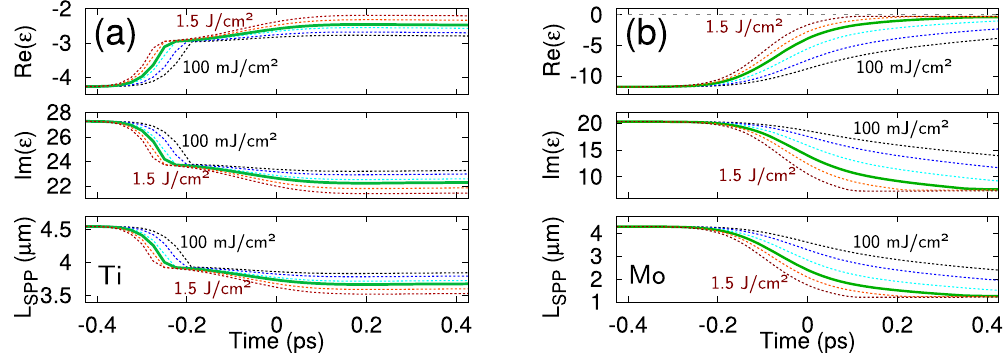
Figure 4. Estimations of dynamic changes of the optical properties upon irradiation of Ti ( a ) and Mo ( b ) by a 213 fs laser pulse at λ = 1030 nm. Variations of the real and imaginary parts of the dielectric permittivity ε and the associated SPP decay length are shown at different laser fluences (colored lines with increasing fluence from right to left): 0.1, 0.2, 0.4, 0.6, 1.0 and 1.5 J/cm 2 for titanium and 0.1, 0.2, 0.4, 0.69, 1.0 and 1.5 J/cm 2 for molybdenum. In each graph, the green solid line corresponds to the experimental fluence (averaged over the irradiation spot) at which the reported LIPSS were